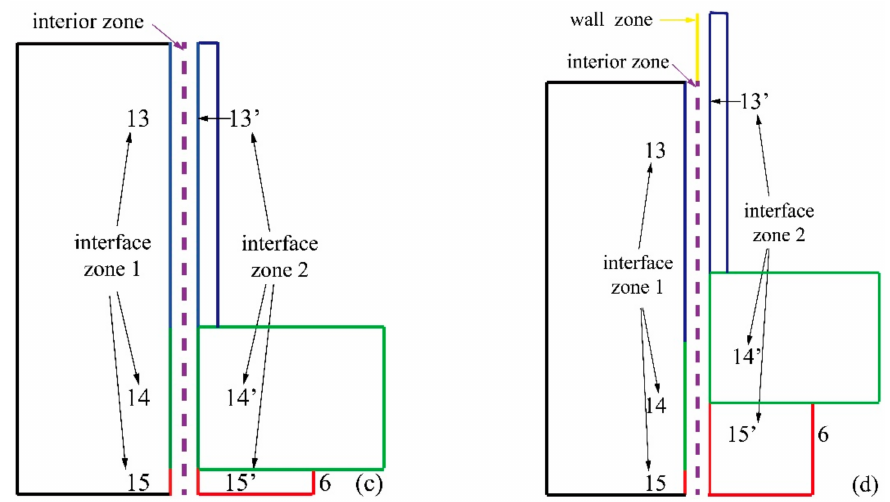
Figure 2. Geometric model of ESRC: ( a ) zone and size; ( b ) boundaries; ( c ) no movement; ( d ) movement.